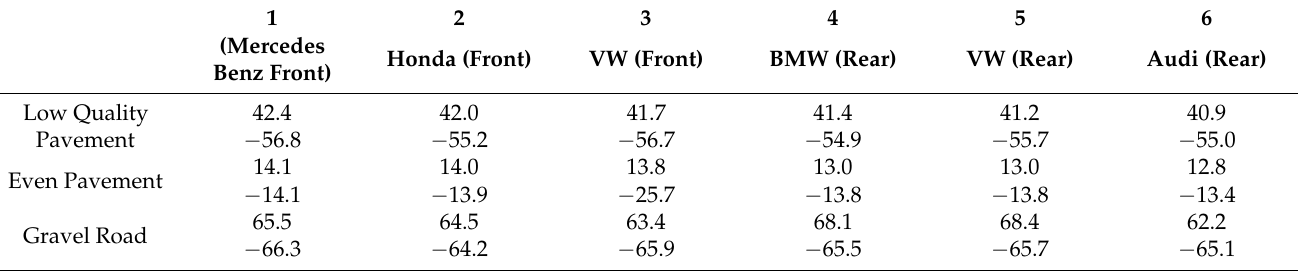
Table 2. Vertical travel of the wheel